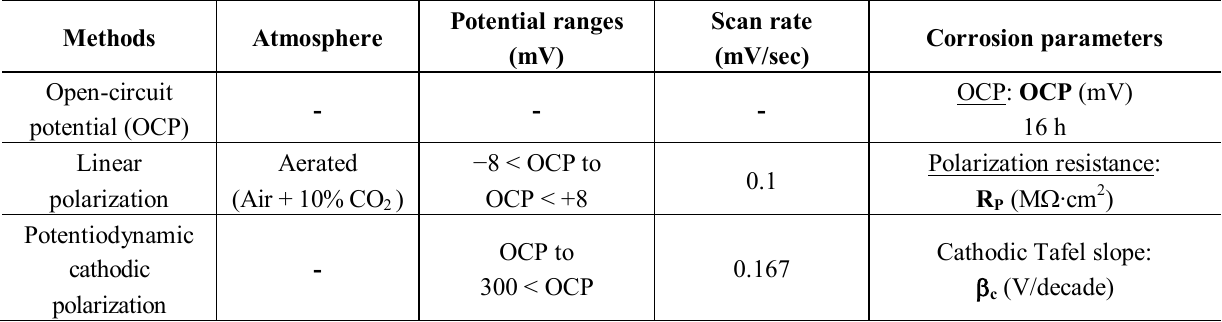
Table 3. Experimental conditions for determination of corrosion